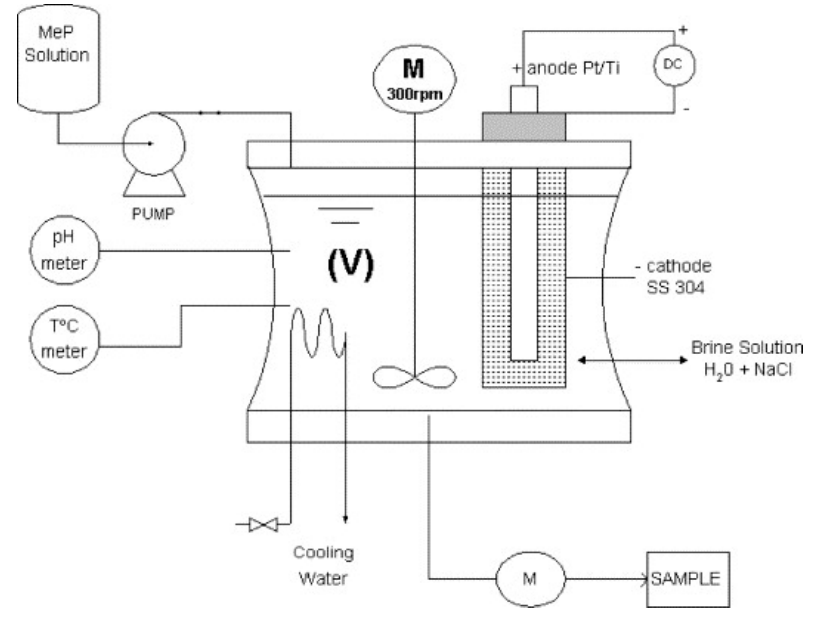
Figure 3. Electro-Fenton schematic (adapted from